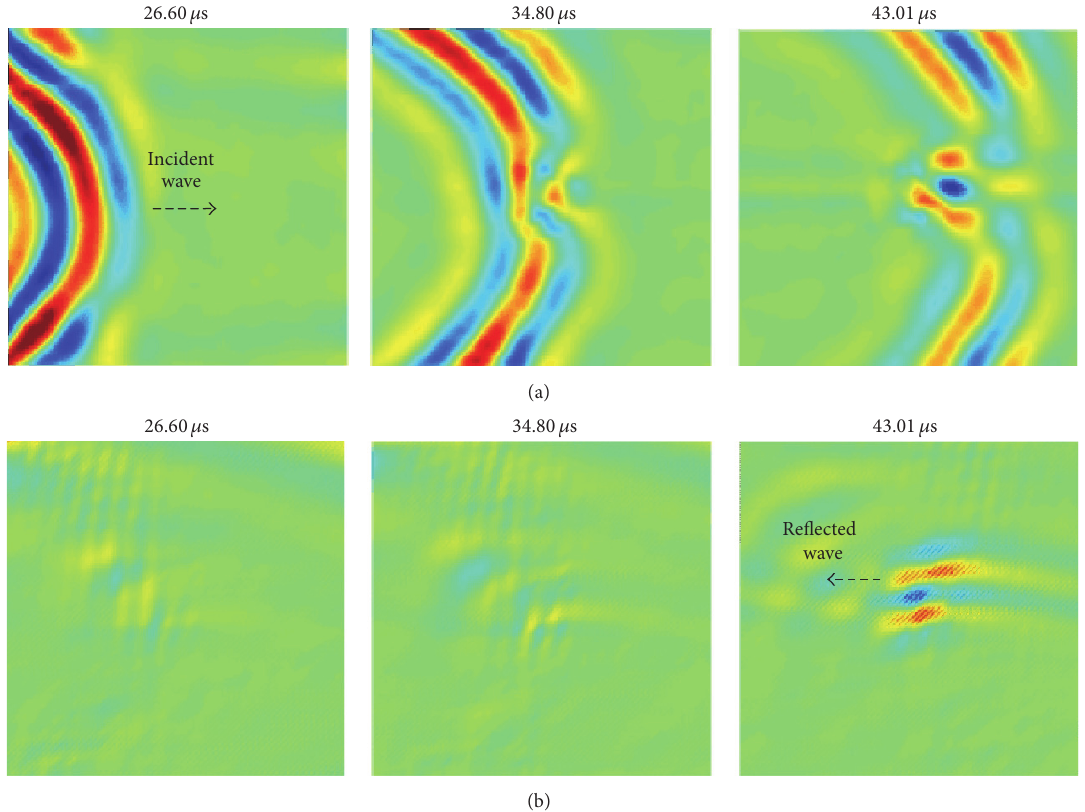
Figure 7: Decomposed wavefield images: (a) 𝑊 𝐹 and (b) 𝑊 𝐵 images.